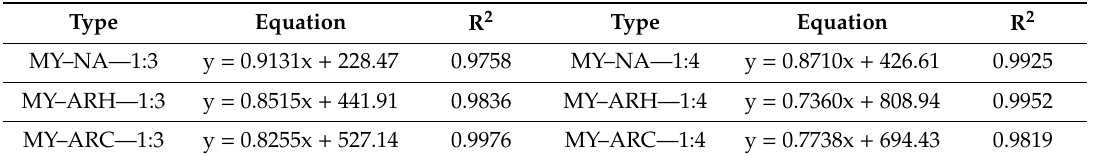
Table 6. Linear regression adjustments and R 2 coe ffi cients for the relationship of speed measurements obtained by ultrasound and by the Arduino